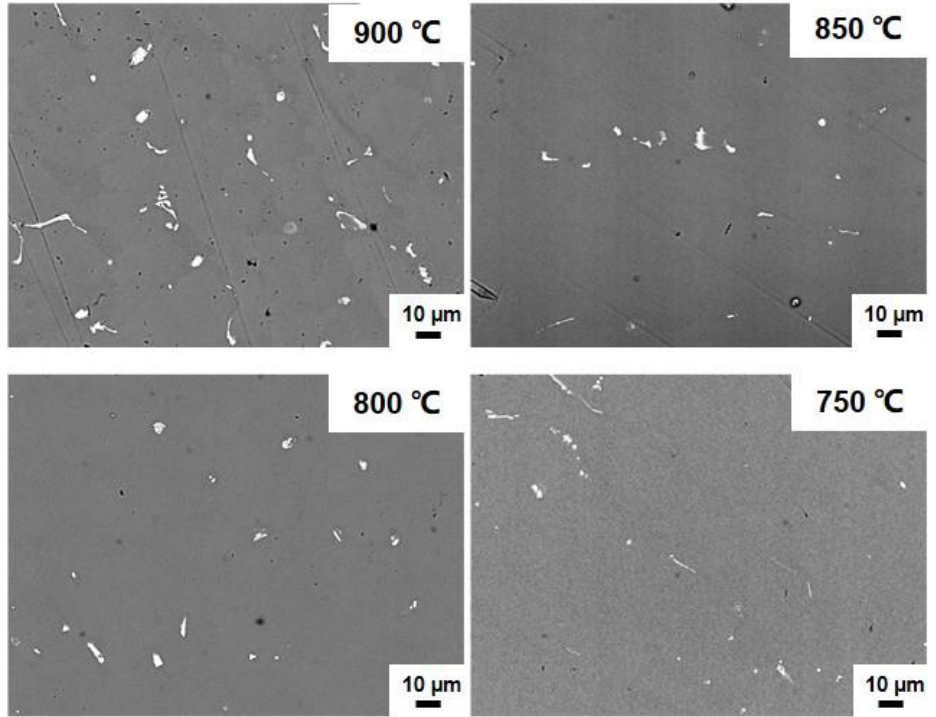
Figure 9. SEM images of microstructure of master alloys produced at various temperatures. Agitation time was 20 min. Table 1. Average composition (atm.%) and average aspect ratio of particles of the first type. Tempera-